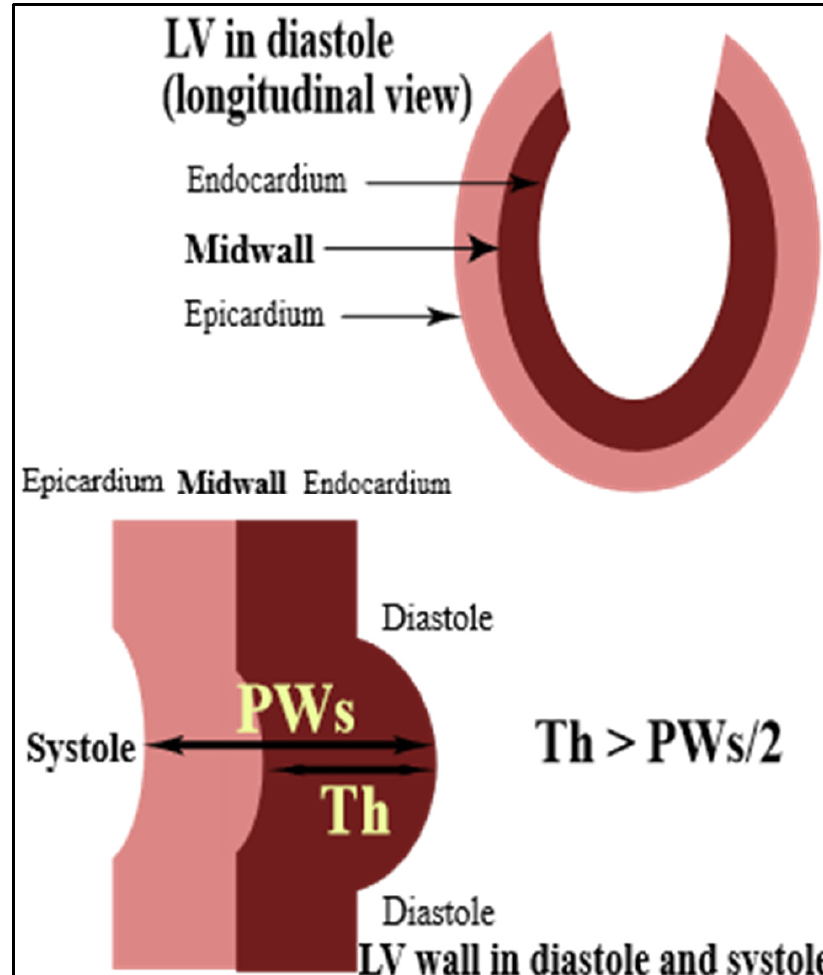
Figure 1. LV is represented by 2 concentric shells with the LV midwall located at the mid-point of the LV wall at end-diastole (upper panel). In systole, the LV midwall fibers migrate from the midpoint towards the epicardium due to the obvious assumption of a constant volume of the LV inner shell throughout the cardiac cycle. Consequently, Th exceeds PWs/2 (lower panel). LV: left ventricle; PWs: end-systolic LV posterior wall thickness; Th: end-systolic thickness of the LV inner myocardial shell (i.e., between the midwall and endocardium). The calculation of midwall fractional shortening (mwFS) enables avoiding an over- estimation of fractional shortening with conventional endocardial measurements due to radial thickening, but not shortening, of longitudinal subendocardial fibers, especially in patients with concentric LV geometry [14–17]. Accordingly, mwFS [%] was defined as follows (Figure